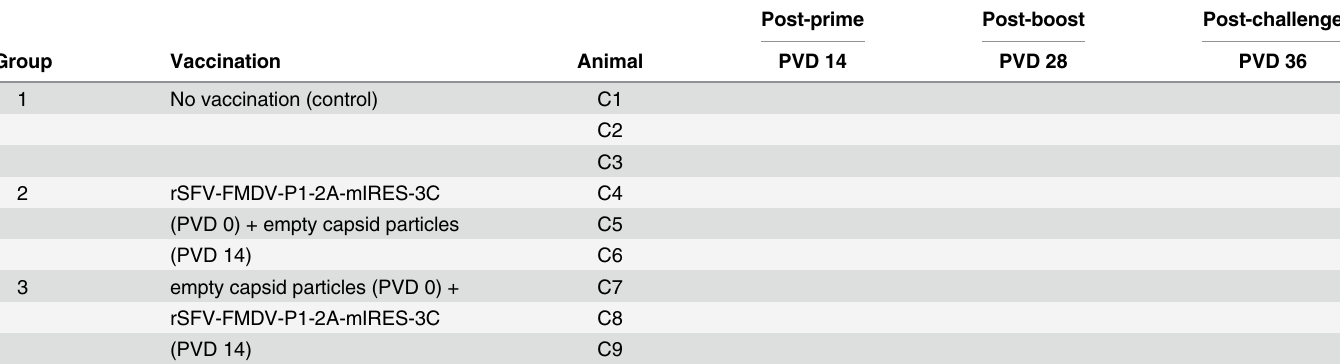
Table 3. Reciprocal titres of anti-FMDV antibodies (serotype O) in sera from calves in experiment 3.